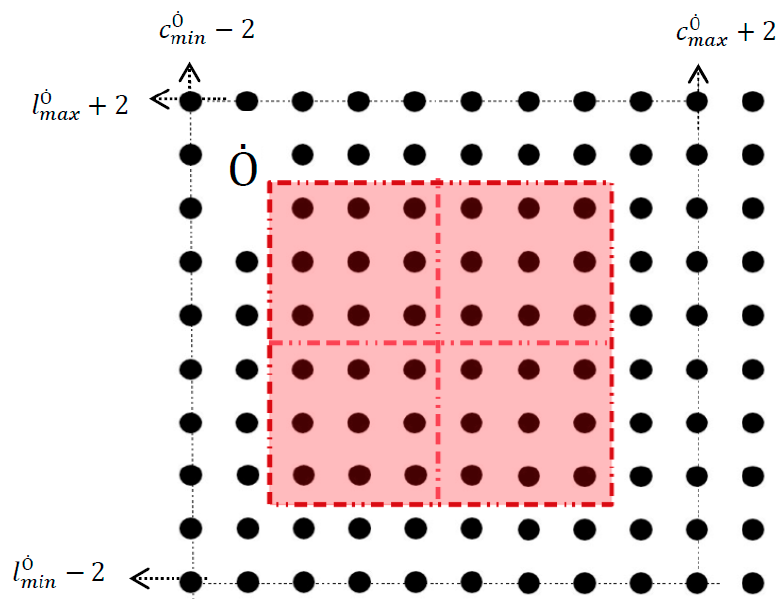
Figure 15. The (cid:1829) (cid:3042)(cid:3029)(cid:3046) Space of the “Smart Platform”. Figure 15. The C obs Space of the “Smart